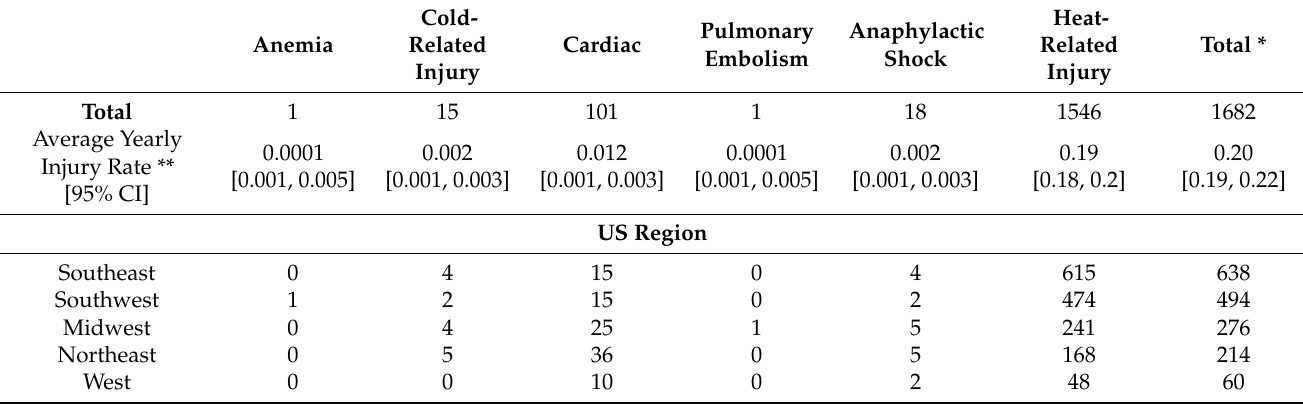
Table 2. Exertion-related injury rates and summary statistics in OSHA Severe Injury Report